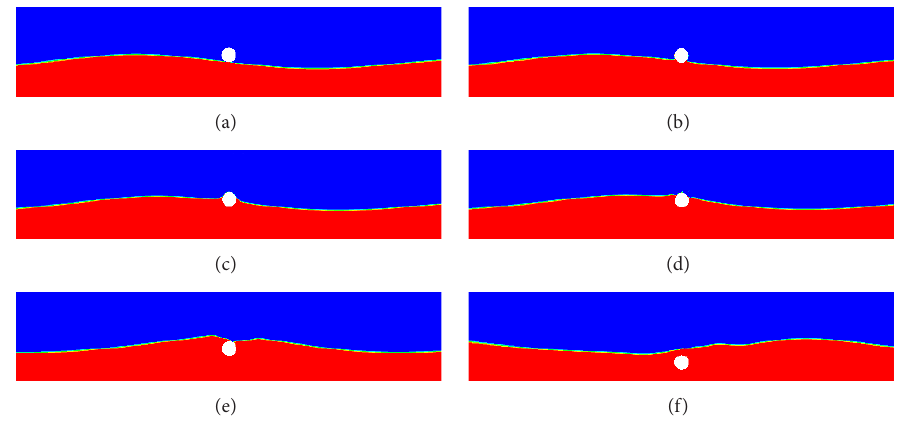
Figure 6: Submergence process of a circular cylinder in waves: (a) 𝑇 = 0.75 ; (b) 𝑇 = 0.775 ; (c) 𝑇 = 0.84 ; (d) 𝑇 = 0.9 ; (e) 𝑇 = 1.1 ; (f) 𝑇 = 1.6 .